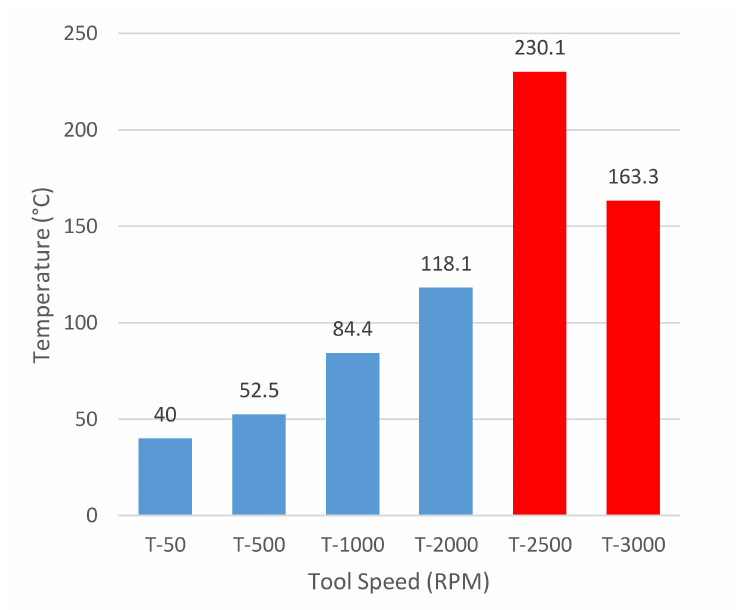
Figure 9. Maximum temperature rises as a function of rotational speed during ISF of T6- AA-2219 sheet: red bars represent fractured T6 parts.